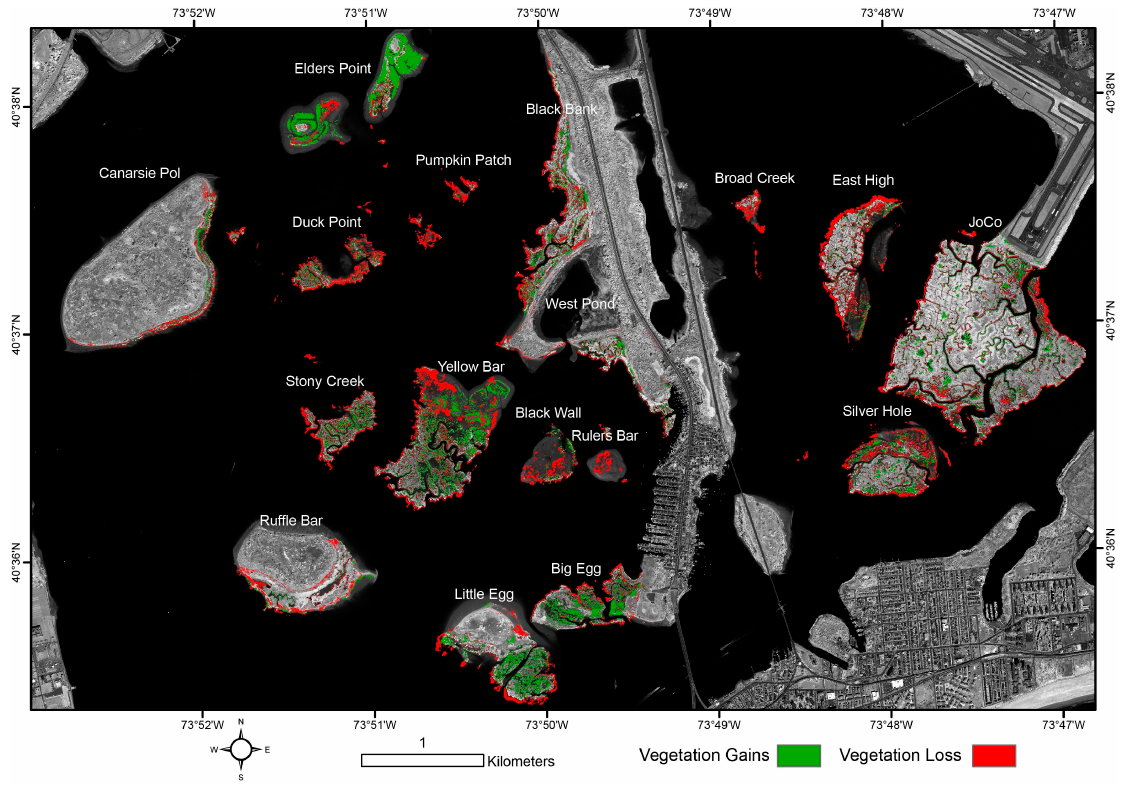
Figure 2. Salt marsh change from 2003 to 2013 displayed on a panchromatic 2013 Worldview-2 imagery.